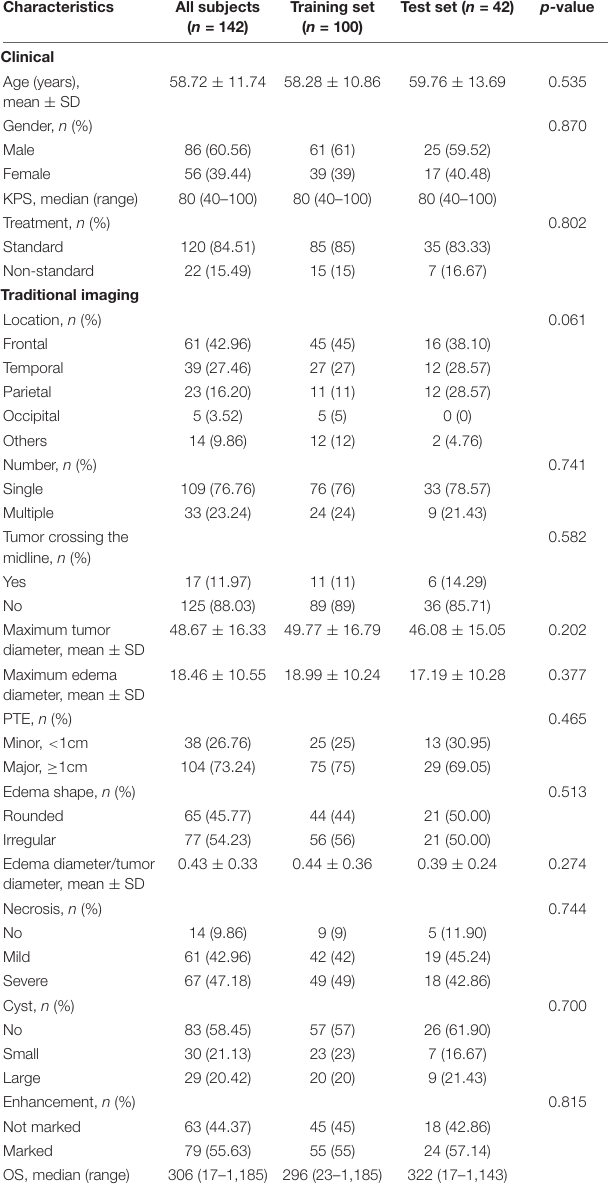
TABLE 1 | Clinical and traditional imaging characteristics of patients included in the